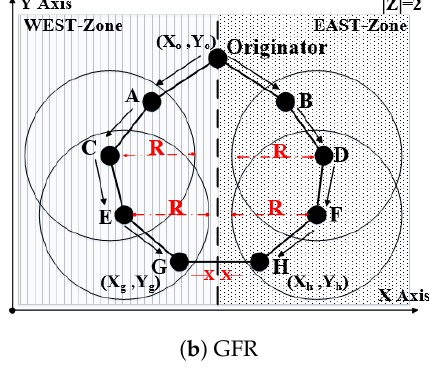
Figure 9. Zone MPR computation of modified OLSR.